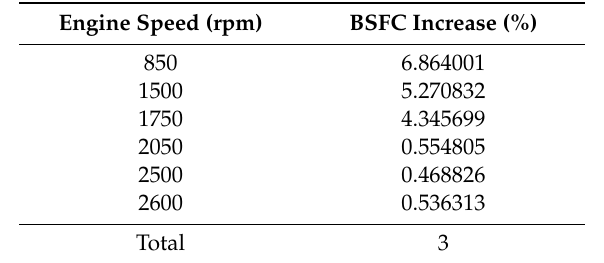
Table 6. T / C system analytical BSFC increments. Table 6. T/C system analytical BSFC increments.